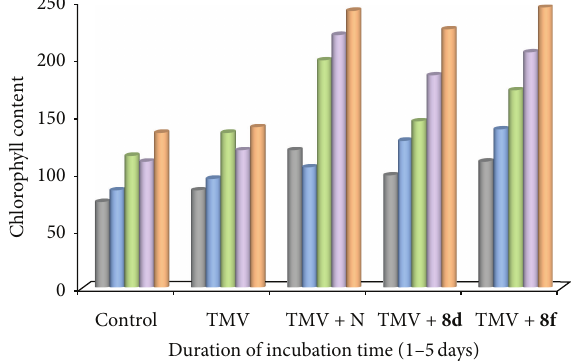
Figure 2: Change in the chlorophyll content in the tobacco leaves after treatment with 8d and 8f . (PDA) medium (Hi-Media). A loop full of culture from the slant was inoculated into the Potato Dextrose broth and incubated at 37 ∘ C for 48–72 h. This culture (0.1 mL) was spread on the potato dextrose agar plate and a sterile glass spreader was used for even distribution of the